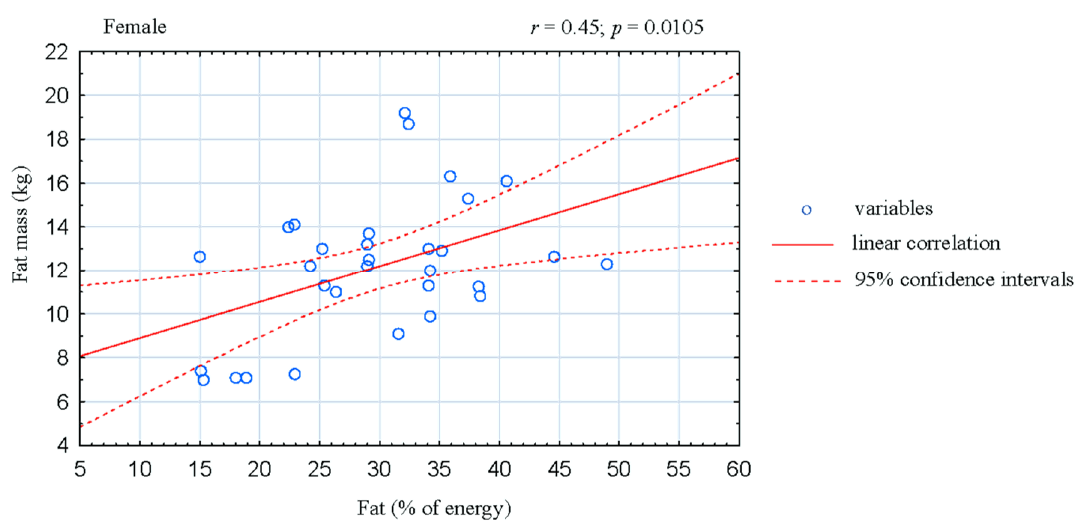
Figure 2. Correlation between dietary fat intake and body fat mass in female CrossFit-trained individuals.